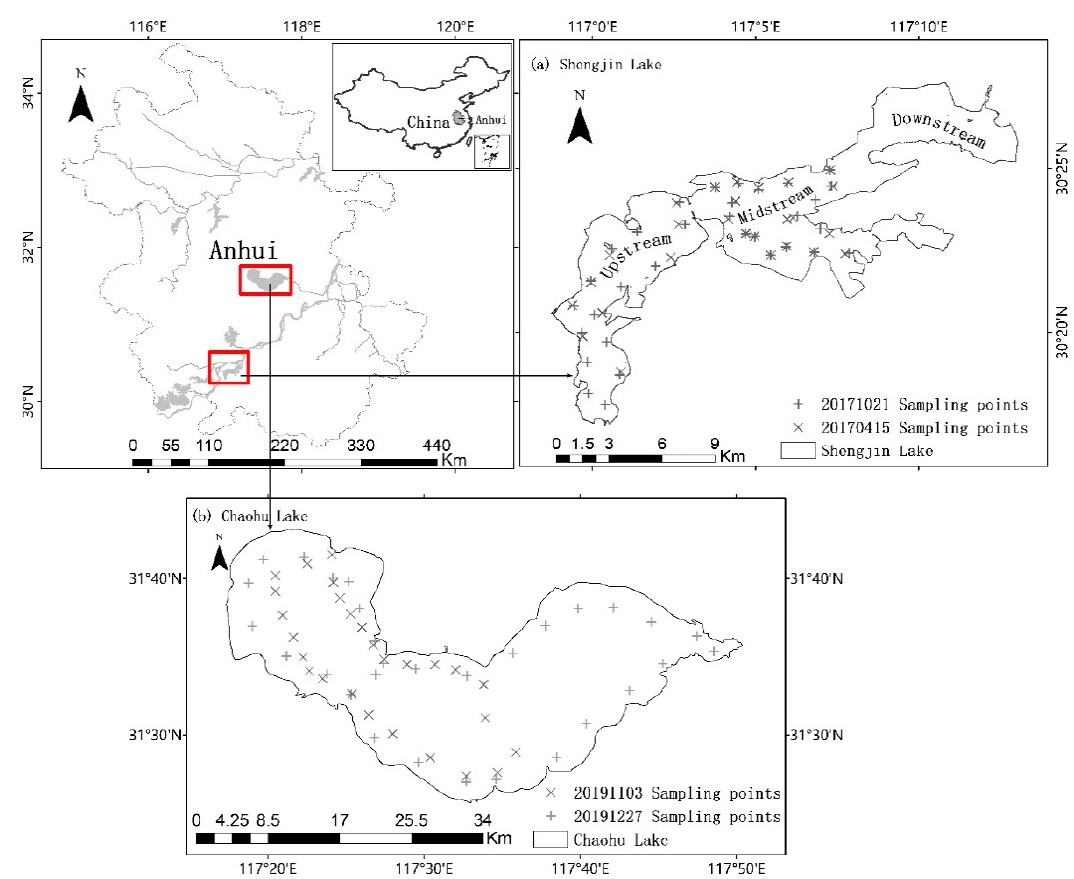
Figure 1. Location of study area and sampling sites. ( a ) Shengjin Lake, ( b ) Chaohu Lake.